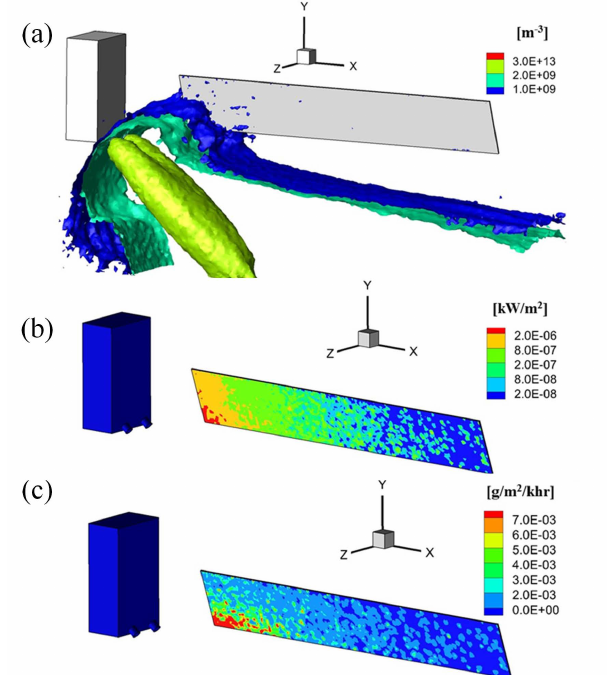
Figure 17. ( a ) Number density distribution of Xe + when two paralleled LIPS-200 ion thrusters are firing, which is simulated by EX-PWS. ( b ) The heated flux loaded on the solar panel. ( c ) The sputtered particle on the solar